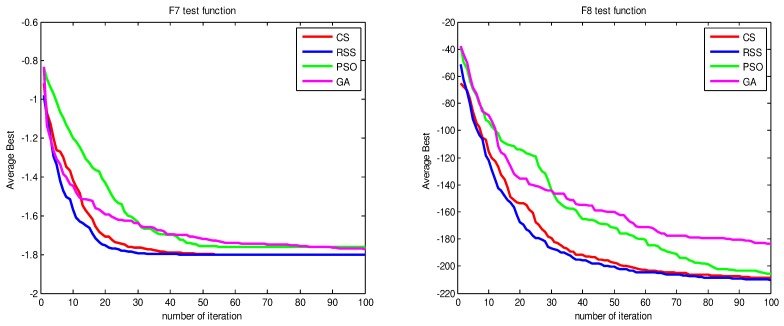
AB convergence of CS, RSS, PSO and GA for minimization of (a) F7 and (b) F8.